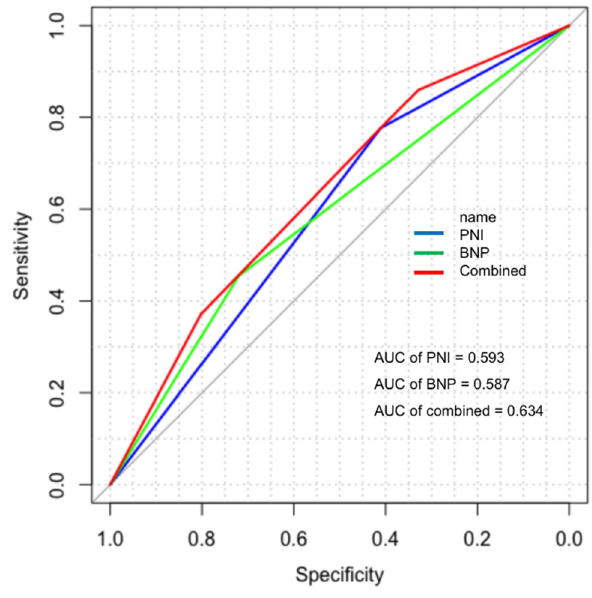
Figure 4. ROC curve for PNI, BNP, and combined indicator.